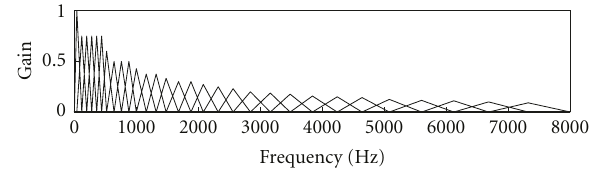
Figure 2: A mel filterbank in which the gain of each filter is scaled by its bandwidth to equalize filter output